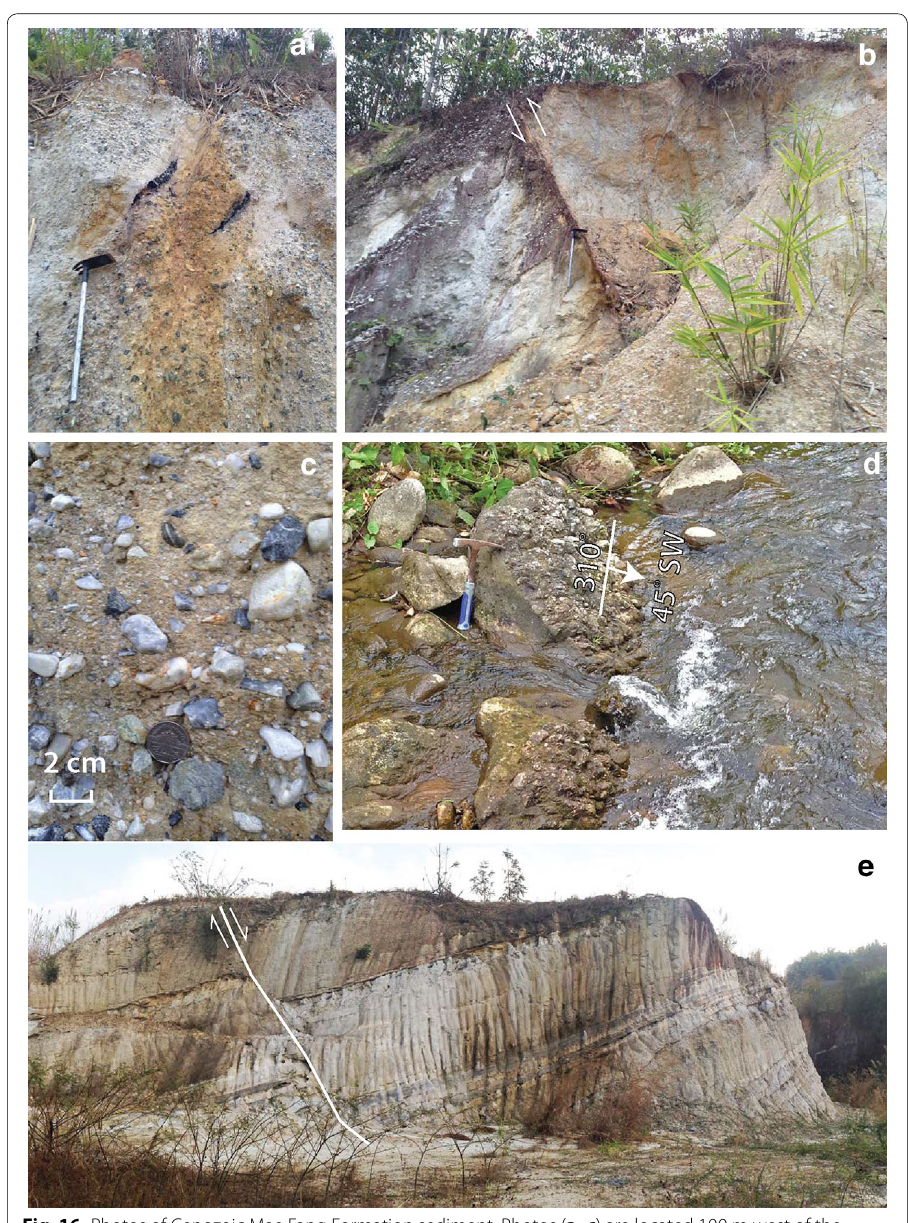
Fig. 16 Photos of Cenozoic Mae Fang Formation sediment. Photos ( a – c ) are located 100 m west of the national park check station on the road to Doi Pha Hom Pok at (520495E, 2207547N). a Clayey, sandy gravel with lenses of coalified wood dipping 44°SE. b Reverse fault (strike of 070°, dip of 61°NW) in sandy gravel. Footwall sediments dip 44°SE. Digging hoe, 1 m long, for scale. c Close-up photo of sandy gravel of photo ( a ). Clasts are entirely dark gray to white quartzite with white quartz veinlets. d Sandstone and conglomerate (strike 310°, dip 45°SW in the bed of the Nam Mae Chai (river), on the immediate SE side of the Mae Chan fault (516790E, 2206410N)). e Normal fault (strike 025°, dip 39°NW, 2 m offset) in pebbly sandstone of the Mae Fang Formation striking 001° to 335°, and dipping 25° to 34°. Base of section (lower right) is 2 m of gray silt with coalified plant detritus. Excavation is 11 m high. Location is 700 m west of Ban Hua Na School at (513584E, 2203193N)